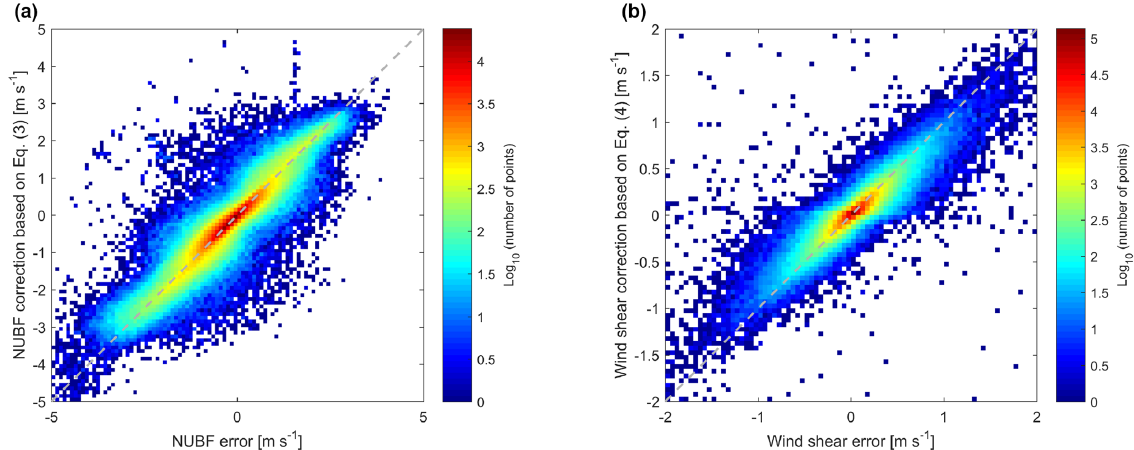
Figure 10. (a) Density plot for the 8-day CloudSat data set illustrating the NUBF-induced (wind-shear-induced) bias vs. bias correction estimated according to Eq. (3) (Eq.